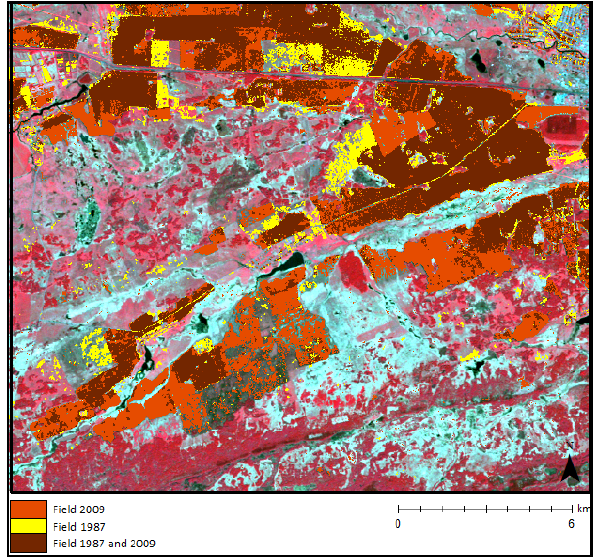
Figure 8 Change detection of agricultural land use in the SASCHA test site of Omutinsky (Tillmann